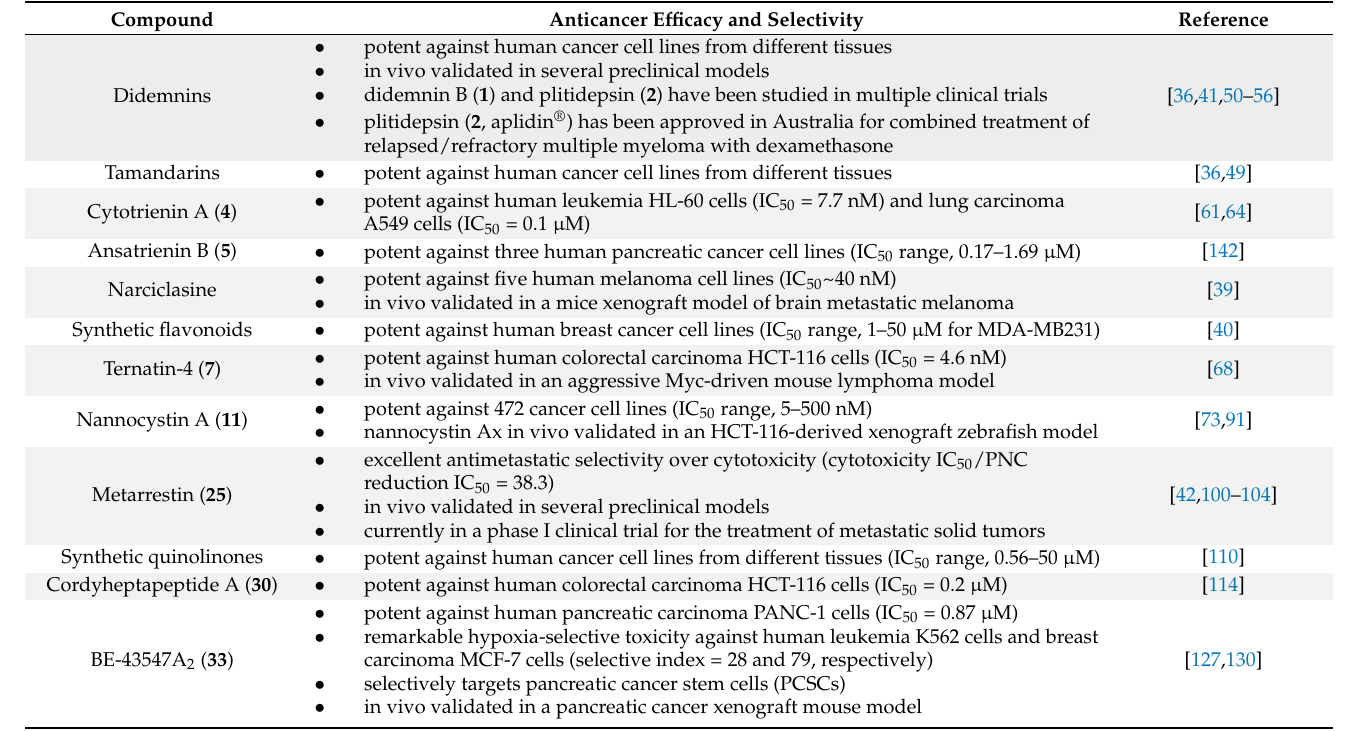
Table 3. Summary of eEF1A-targeting small-molecule agents on their anticancer efficacy and selectivity. Compound Anticancer Efficacy and